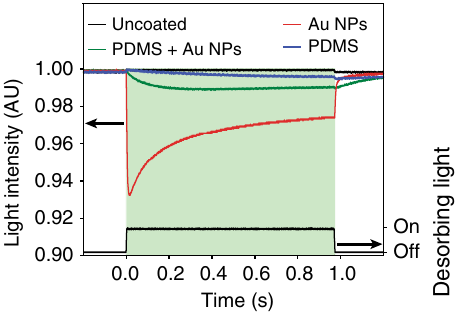
Fig. 5 Compatibility of Au NP coating with conventional polymer coatings. The Au NP coating is compatible with the anti-relaxation properties of PDMS that are key for quantum optical applications. The increased absorption of Rb was recorded for all four vapor cells when illuminated with a green laser pulse at 532 nm, at 17°. The uncoated reference cell (in black) shows no increase in Rb absorption. The Au NP only coated cell (in red) shows the largest increase in Rb absorption, and it quickly returns to the initial absorption depth after the desorbing light pulse. The PDMS only coated cell (in blue) undergoes a small increase in absorption during the desorbing light pulse, which slowly decreases, afterwards. By comparison, the cell coated with both PDMS and Au NPs (in green) demonstrates faster and more than two-fold increase in